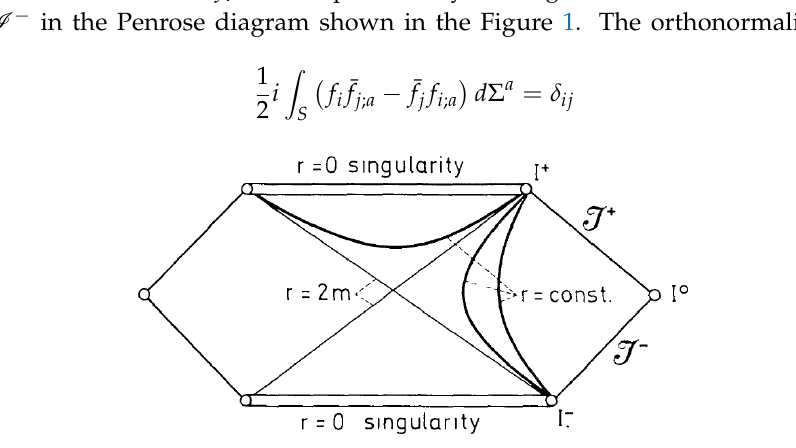
Figure 1. The Penrose diagram for the Schwarzschild geometry in general relativity (GR) as is shown in [22]. In massive gravity, the same diagram is valid if we express the black hole solutions in terms of the Stückelberg functions, defining then the time coordinate in agreement with T 0 ( r , t ) . We note that for arbitrary time definitions, the same diagram will not be valid even if we have a zero cosmological